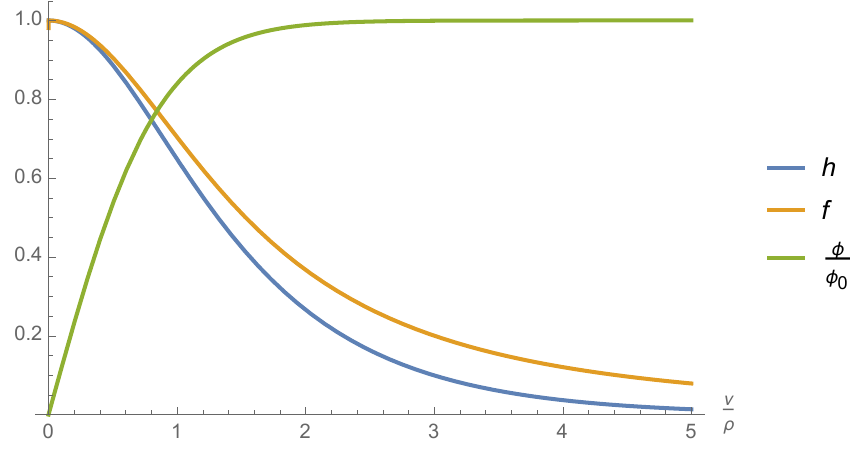
Figure 11 . Graph of the exact double BPS hedgehog solutions ( l = 3) for q =